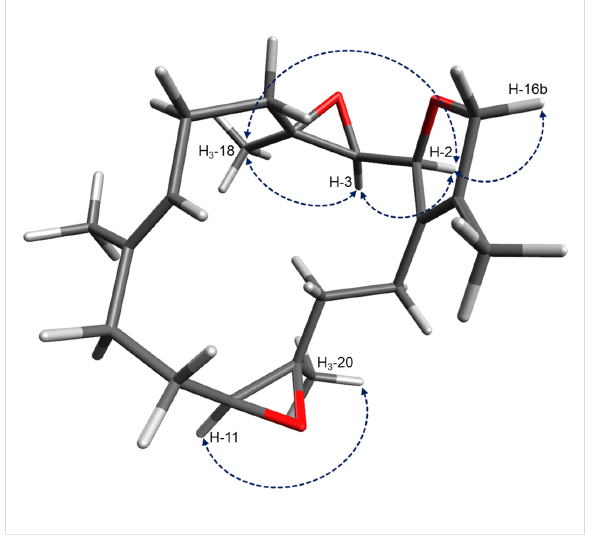
Figure 8: Proposed configuration and selected NOE correlations of bisepoxide 12 (key NOE correlations are indicated with blue arrows).